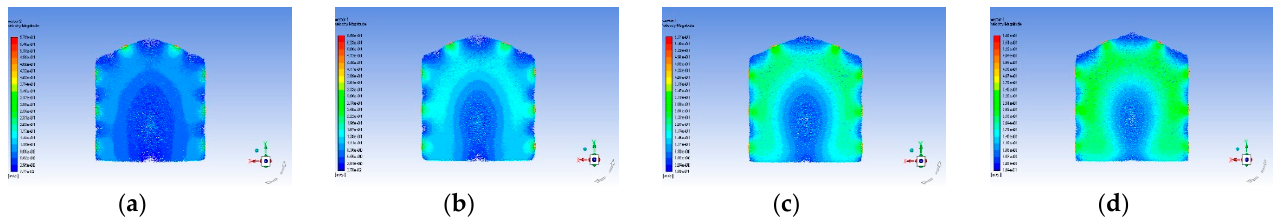
Figure 5. Structural model of diversion boxes with different angles of diversion plates. The angles of the deflector in the picture are ( a ) 150°, ( b ) 160°, ( c ) 170°, and ( d ) 180° from left to right.